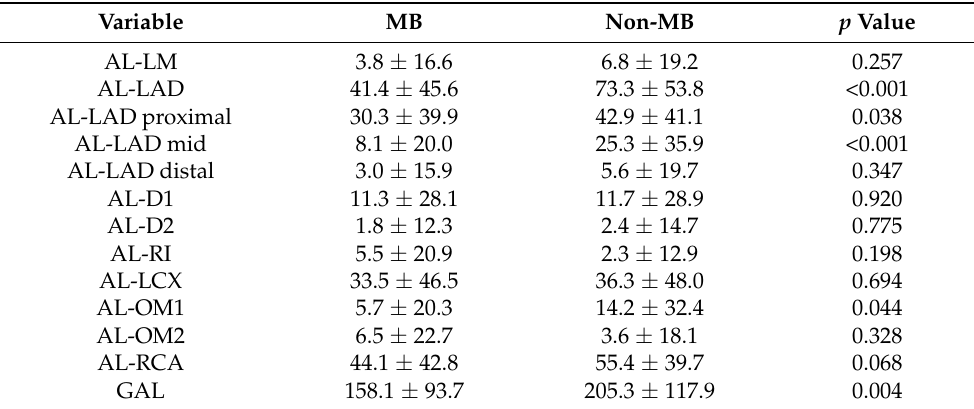
Table 3. Atherosclerotic load in patients with and without MB.